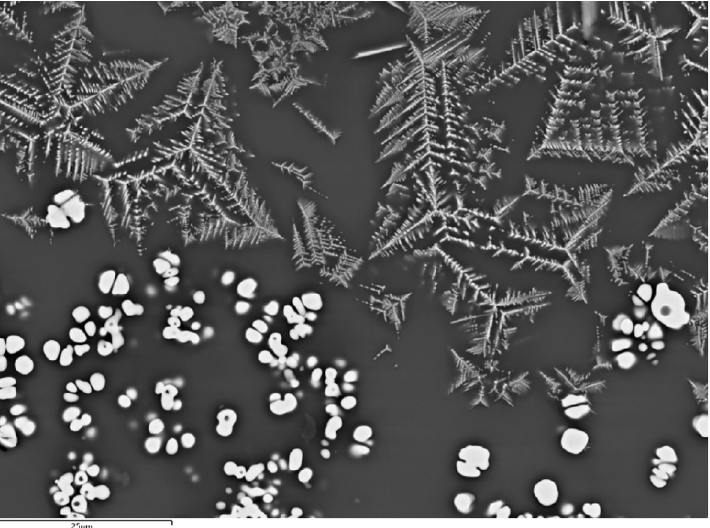
Fig 10. BSE micrograph of G11 showing a closer view of part of Fig 7. Metallic Cu-based prills can be seen together with skeletal cuprite. (Scale = 25 μ m).